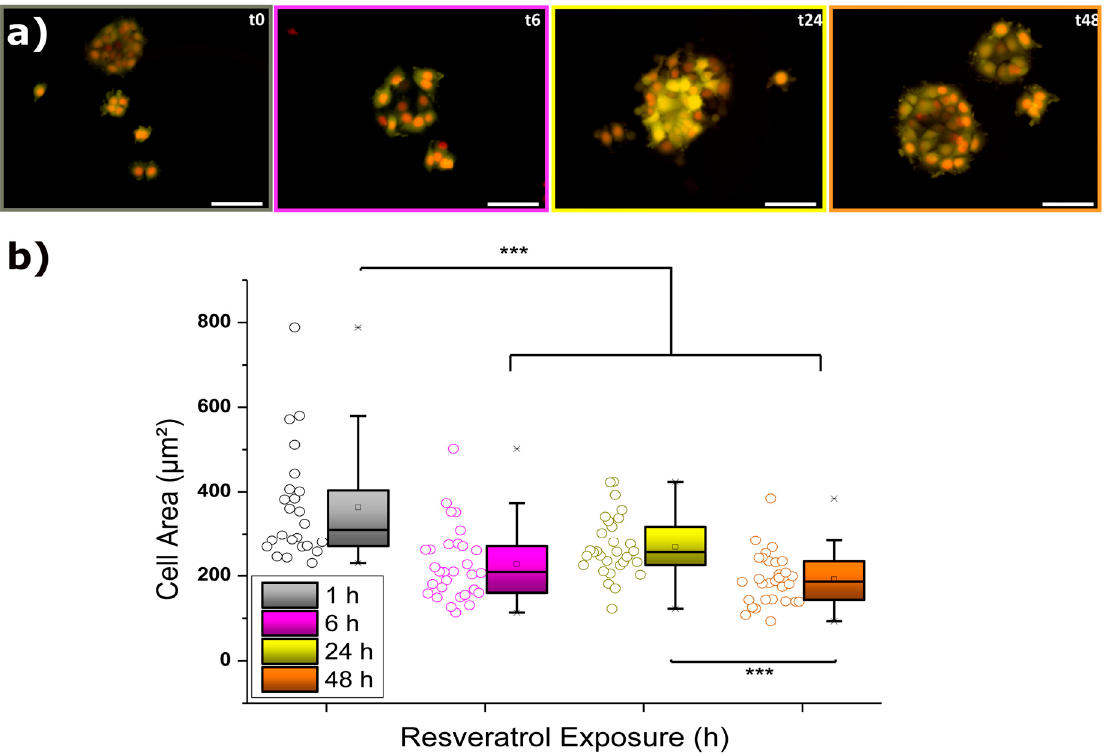
Figure 1. ( a ) Time-dependent fluorescence microscopy imaging of MCF-7 cells exposed to 50 µM resveratrol. Cell bodies (Calcein-AM) appear in yellow, and nuclei (Hoechst 33342) appear in red/orange. Scale bars correspond to 50 µm. ( b ) Corresponding cell area evolution resulting from N = 30. The crosses (x) indicate achievement of either the 1% or 99% of the total population, the square ( □ ) in the box plot represents the mean value, the box-splitting horizontal line gives the median, and the upper and lower value of the box express the achievement of either the 95% or 5% of the population, respectively. Significance of the variations in the p < 0.001 level is indicated accordingly by (***) symbol.